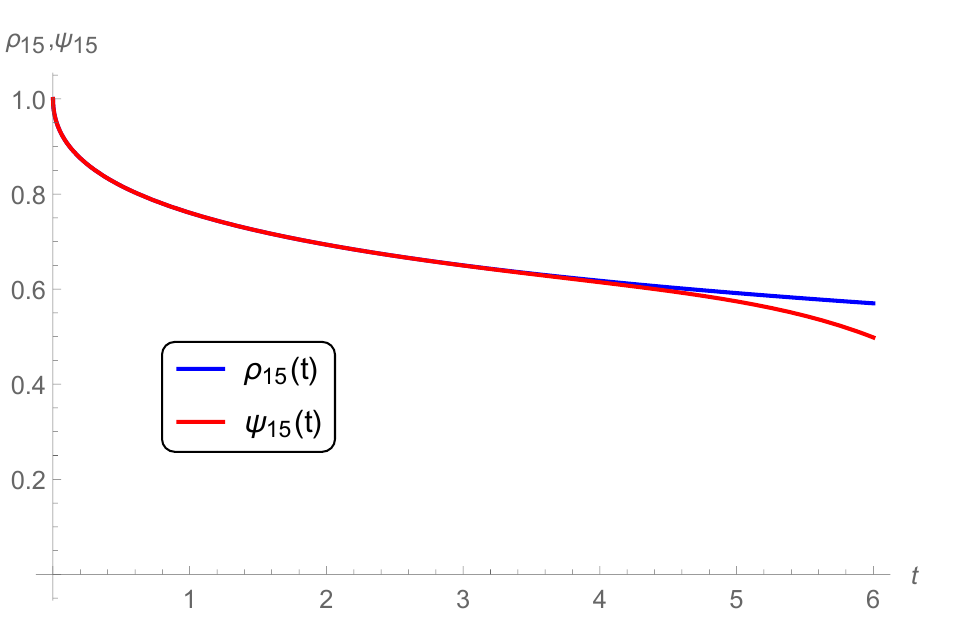
Figure 8. Graphs of the n -th approximate solutions ρ 15 ( t ) (present) and Ψ 15 ( t ) (Ref. [19]) for λ = 1, q = 1.4, and α = 0.5